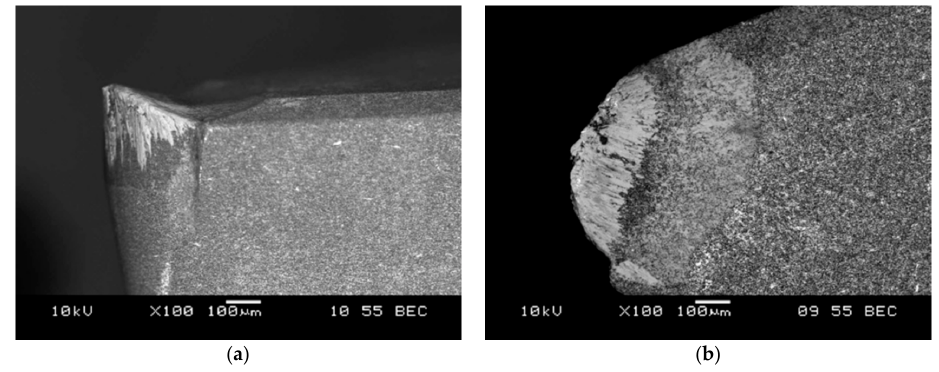
Figure 11. SEM image of DCMW PCD cutting edge after composite machining, wear by accumulations: ( a ) side view; ( b ) top view.